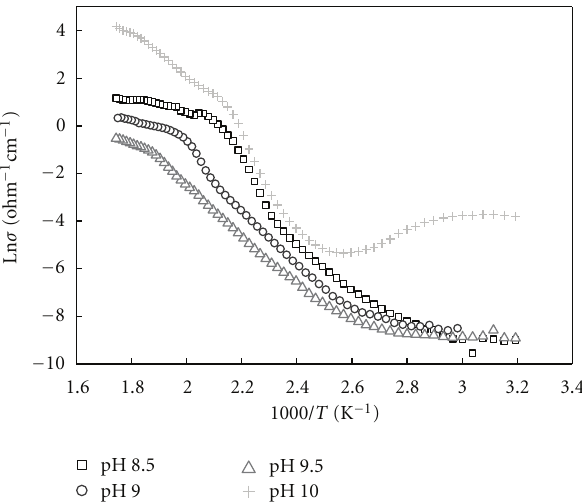
Figure 5: Variation of ln σ versus 1000/T for Cd 1 − x Zn x S prepared at di ff erent pH values.